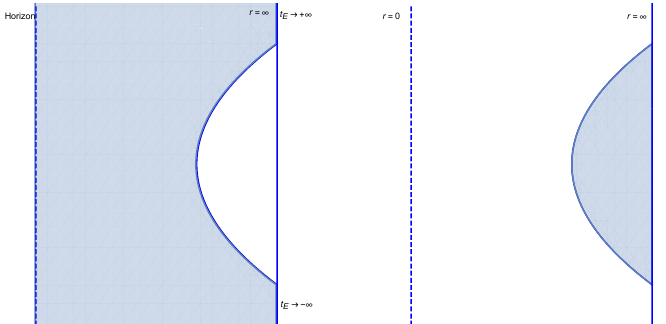
Figure 6 . Unshaded regions provide allowed exteriors (left) and interiors (right) for case (III), where (cid:11) i > (cid:11) e > 0 at all r . Since the Euclidean horizon is always excised, we take Euclidean time to run vertically over ( (cid:0)1 ; + 1 ). Wick rotating to Lorentz signature yields time symmetric collapsing-shell solutions, where a domain wall outside its horizon at t = 0 collapses to form a black hole at late